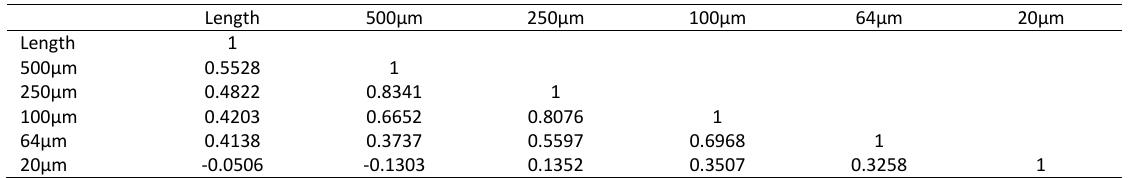
Table 5. Correlation and biplot scores of the 6 explanatory variables